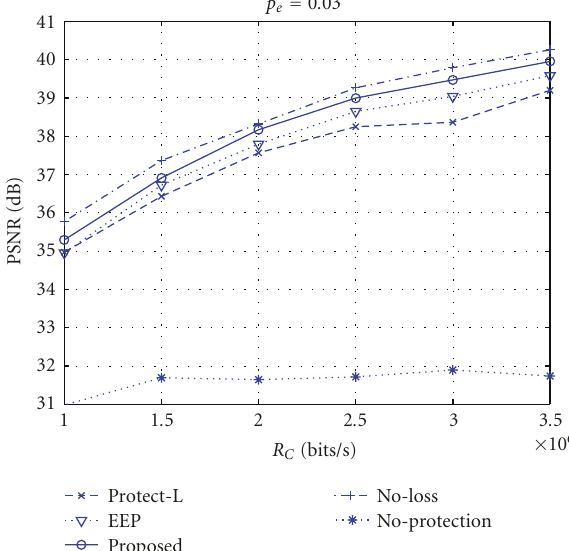
Figure 22: Results for p e = 0 . 03 for “Soccer” video.